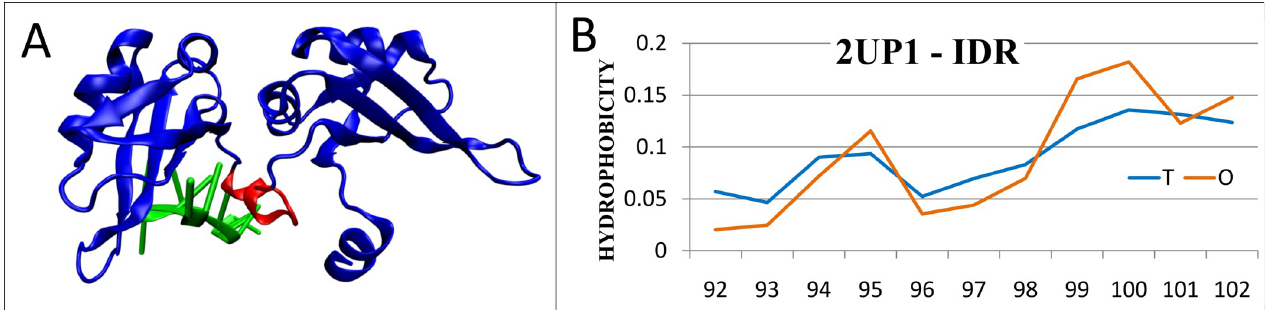
Fig 6. Characteristics of two-RRM domain of hnRNP A1 (PDB ID: 2UP1). A– 3D structure with highlighted IDR (red) and marked single-chain DNA fragment complexed by this protein (green); B–the distributions T and O for the optimal K = 0.